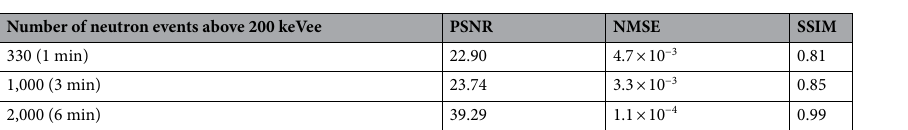
Table 1. Neutron image quality evaluated by using PSNR, NMSE, SSIM as increasing measurement time or the number of counts.